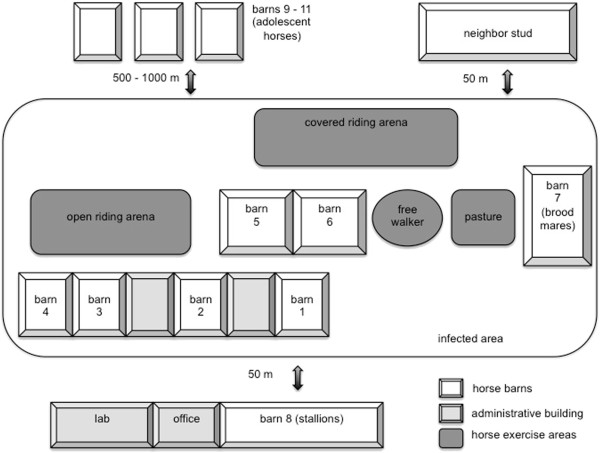
Schematic presentation of the stud (not in scale). A total of 61 clinically affected (fever, abortion, EHM) horses were recorded. For distribution of clinical cases in the barns see Table 1.